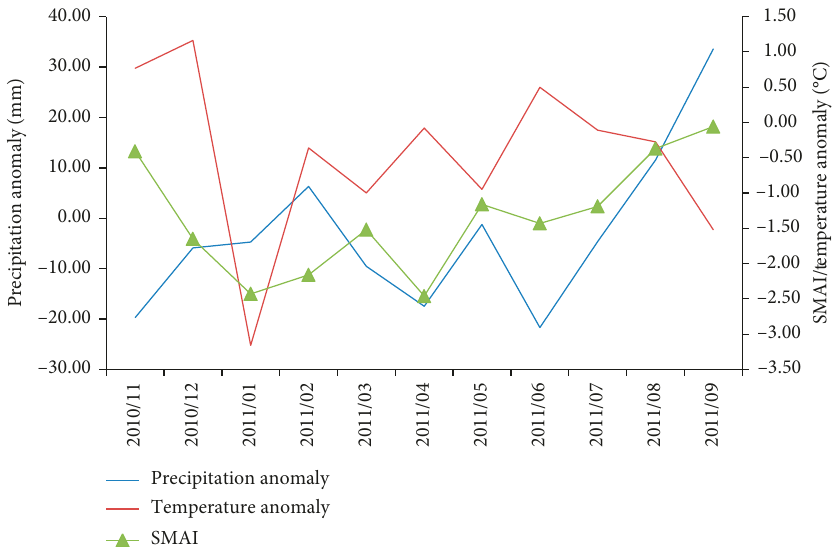
Figure 6: Monthly SMAI and precipitation and temperature anomalies during November 2010 to September